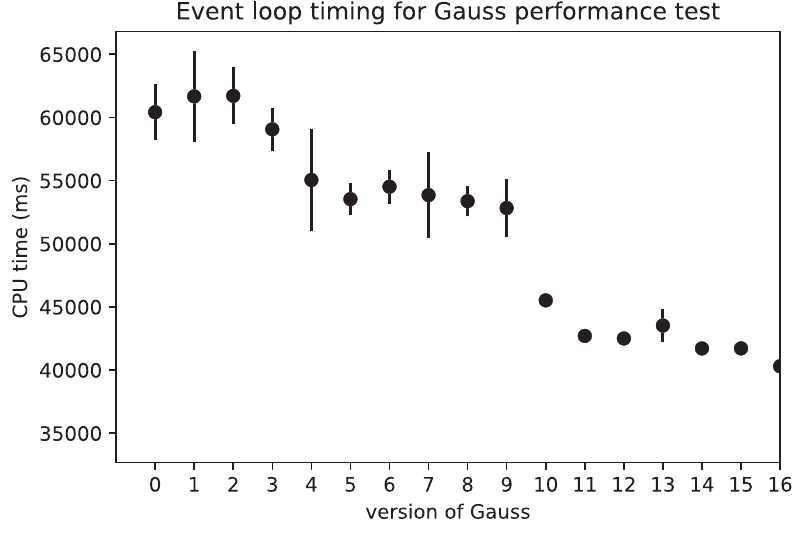
Figure 2. Integration of LHCbPR with Hadoop ecosystem